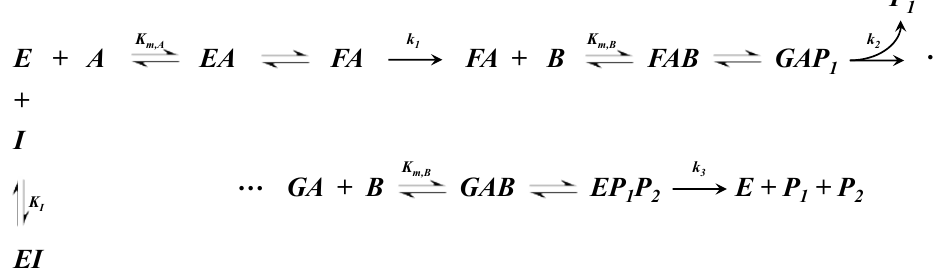
Figure A5. Ping-pong ter-ter kinetics and competitive inhibition of species A through